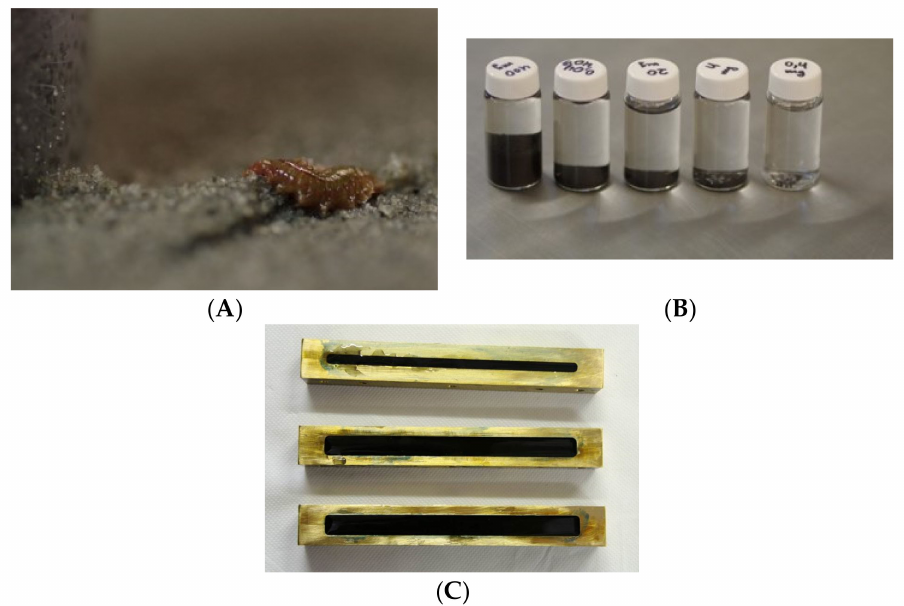
Figure 3. ( A ) Hediste diversicolor and ( B ) graphene flakes for ecotoxicology tests (as described in [8]) with different fillers that were also used for ( C ) nanocarbon modified